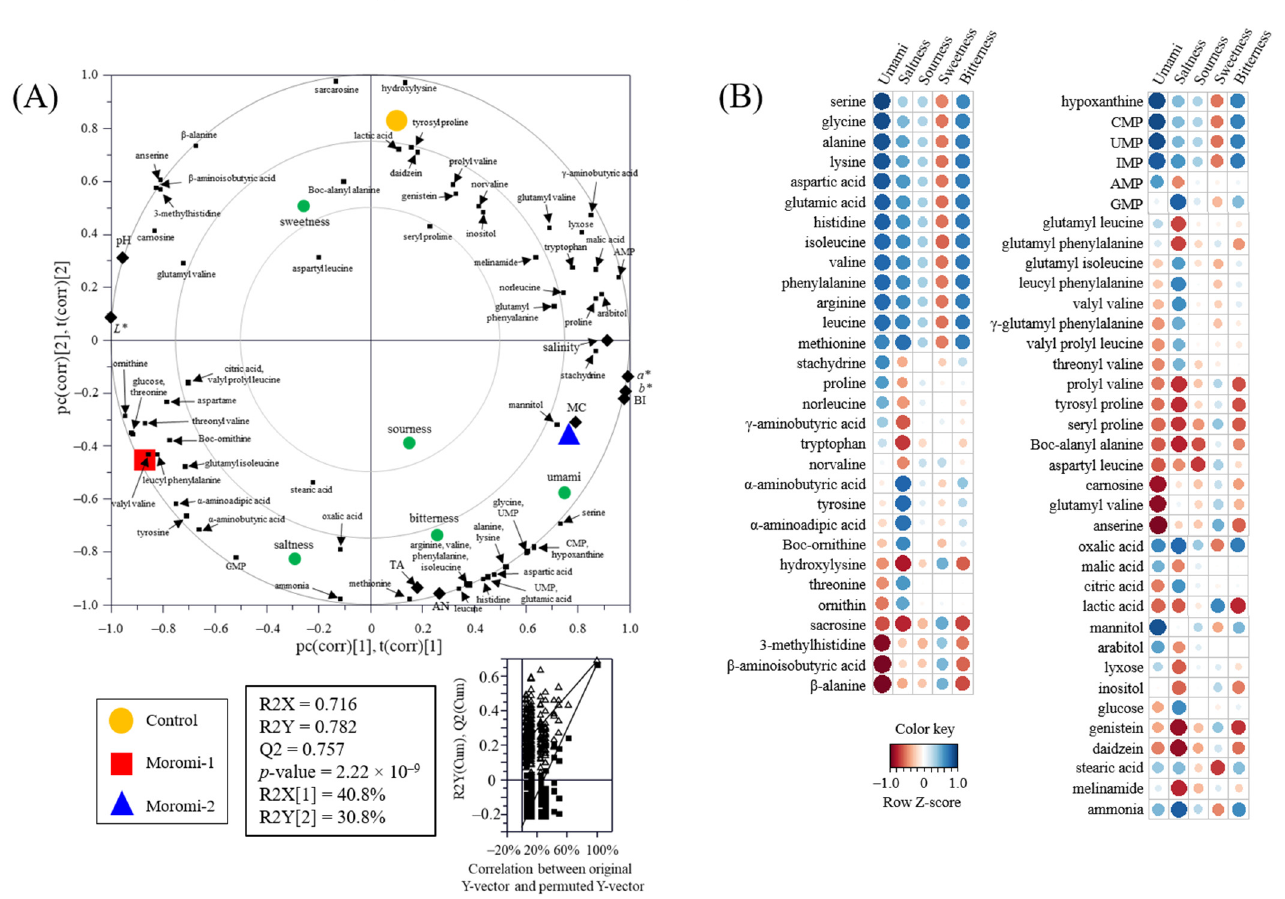
Figure 5. Partial least-squares discriminant analysis (PLS-DA) biplot ( A ) and Pearson correlation between sensory quality and metabolites ( B ). Control, moromi-1, and moromi-2 are moromi samples fermented by commercial strain, A. oryzae KCCM13012P, and A. oryzae KCCM12804P, respectively. PLS-DA biplot was drawn based on the general quality characteristics, sensory quality, and metabolite profiles. The statistical acceptability was evaluated by quality parameters (R2X, R2Y, Q2, and p -value) and validated by cross validation with a permutation test ( n = 200). Correlation heat map colors represent the correlation coefficients, and blue and red colors on a red–blue color scale indicate the positive and negative correlations, respectively. L*, lightness; a*, redness; b*, yellowness; BI, browning index; TA, total acidity; MC, moisture content; AN, amino type nitrogen; CMP, cytidine monophosphate; UMP, uridine monophosphate; GMP, guanosine monophosphate; IMP, inosine monophosphate; AMP, adenosine monophosphate.